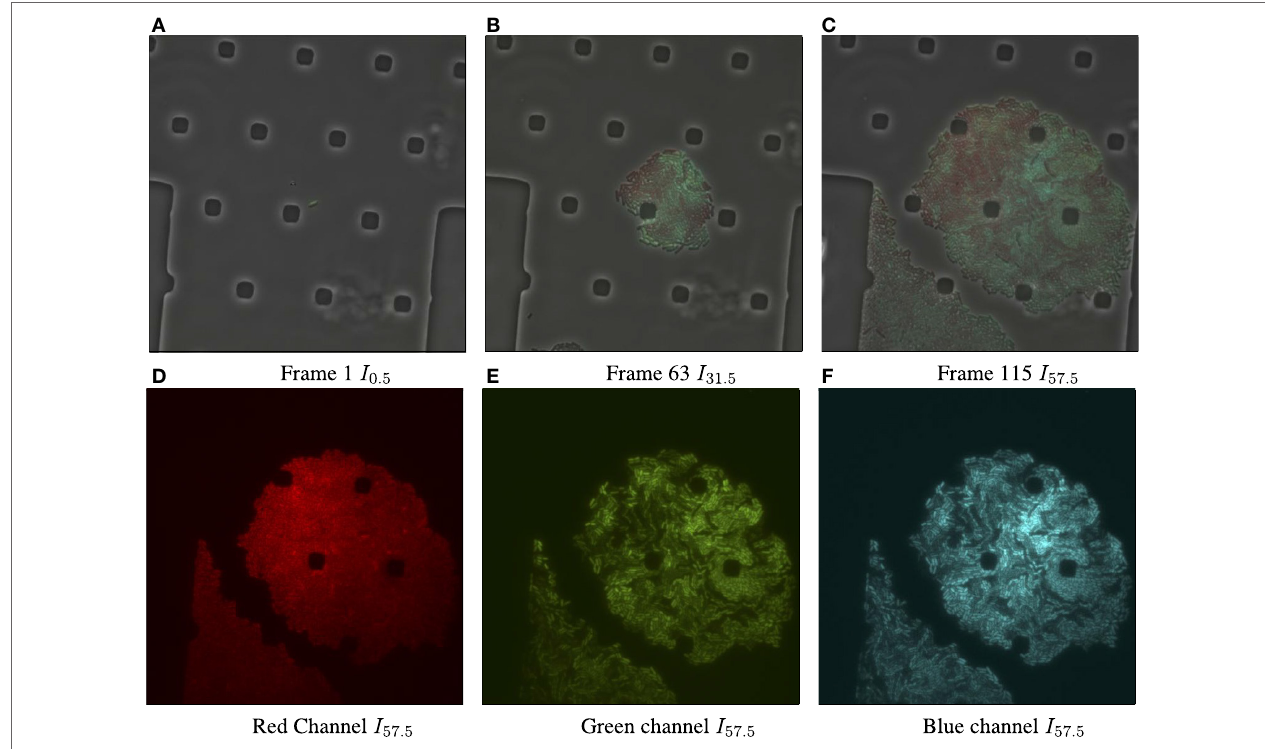
Figure 1 | Input data for biomovie D1, with exposure set to 100%. (a) Original image frame in RGB color space overlaying the luminance channel (phase contrast image) at the first time point. We observe a set of particular and square-like polygons. They are an intrinsic part of the microfluidic chamber, in which bacteria grows. (B) Time 31.5 h. (c) Time 57.5 h, the final frame. (D) The dissociated red channel for the final frame. (e) Green channel. (F) Blue channel.